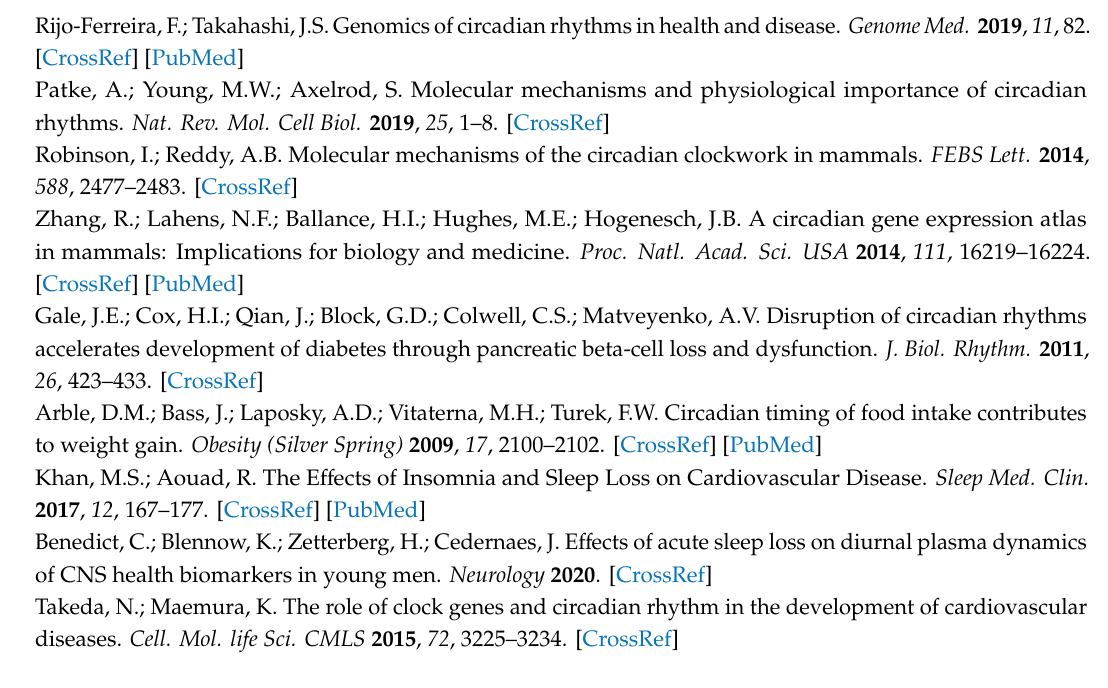
s1. Table S1. Mean levels of gene methylation (%5mC) of the studied population ( n = 55). Table S2. Association between PM 2.5 exposure and clock gene methylation. Table S3. Association between PM 2.5 exposure and NIH-STROKE SCALE (NIHSS) and Modified Rankin Scale for Neurologic Disability. Figure S1. Box plot showing the distribution of PM 2.5 concentrations for the exposure intervals